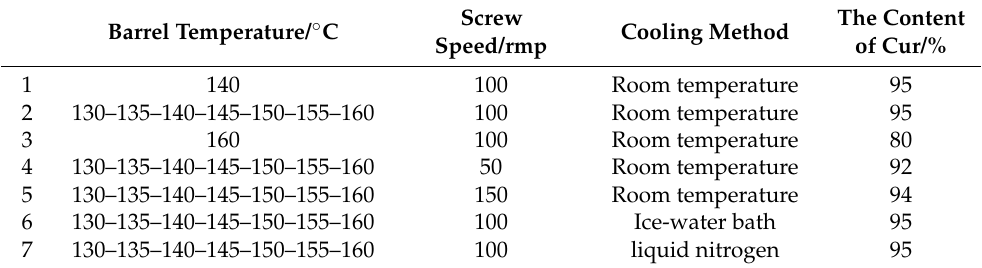
Figure 3. The determination of the carrier ( a ) and the ratio of the carrier ( b ). Table 1. The preparation process of the Cur-EPO